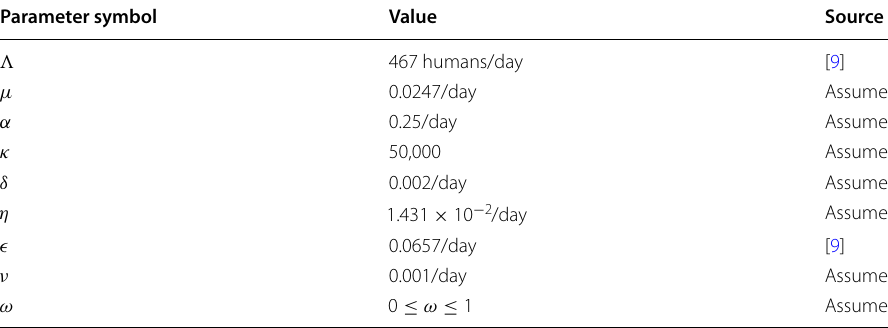
Table 1 Parameter values of the model Parameter